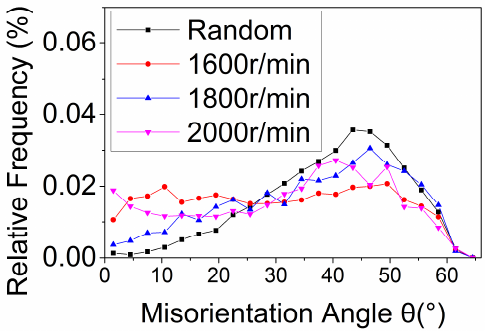
Figure 5. Distribution of misorientation angle at different plug rotation speeds.